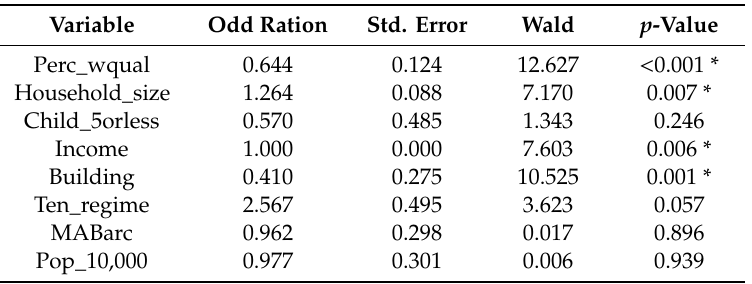
Table 6. Logistic regression model 3